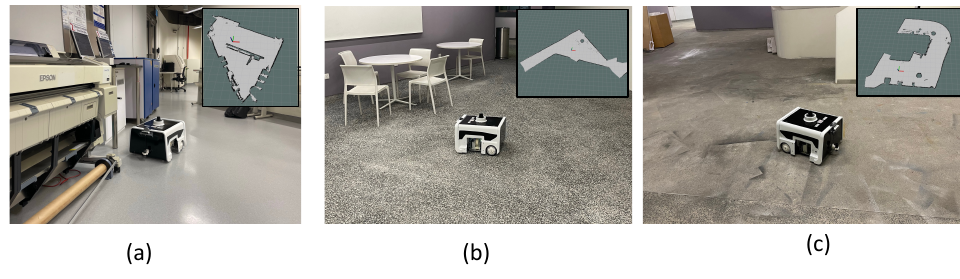
Figure 10. BELUGA robot operating in different environments (map given in inset). Environment-1 ( a ), environment-2 ( b ), and environment-3 ( c ).